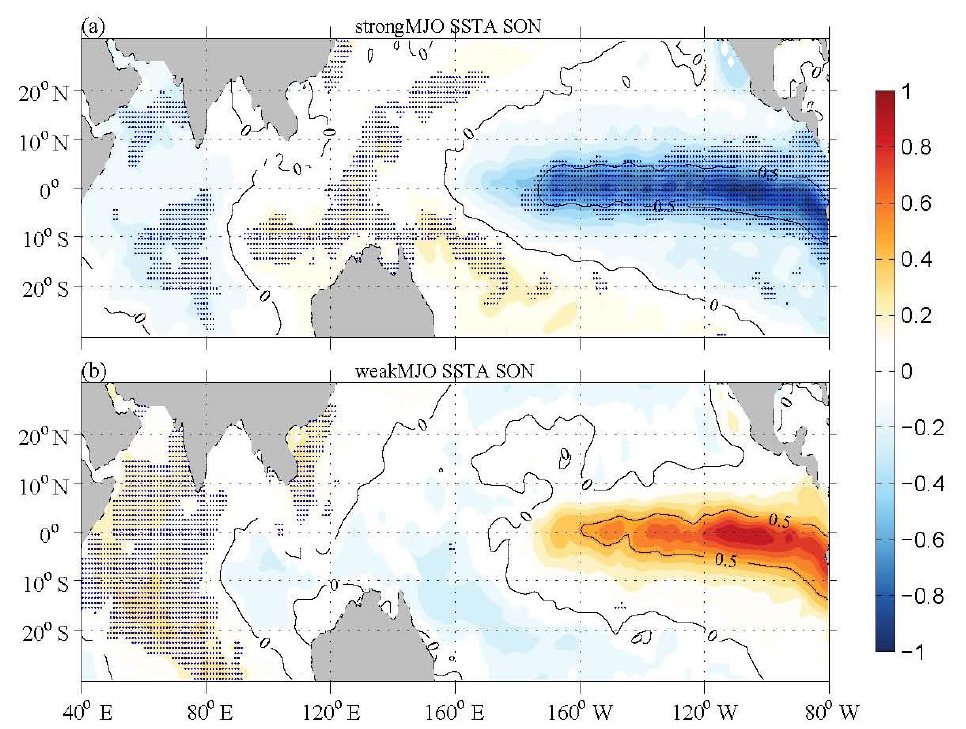
Figure 6. Composite distribution of SST anomalies (°C) in autumn during the ( a ) strong and ( b ) weak MC–MJO cases. Results passing the significance test at the 90% confidence level are stippled.